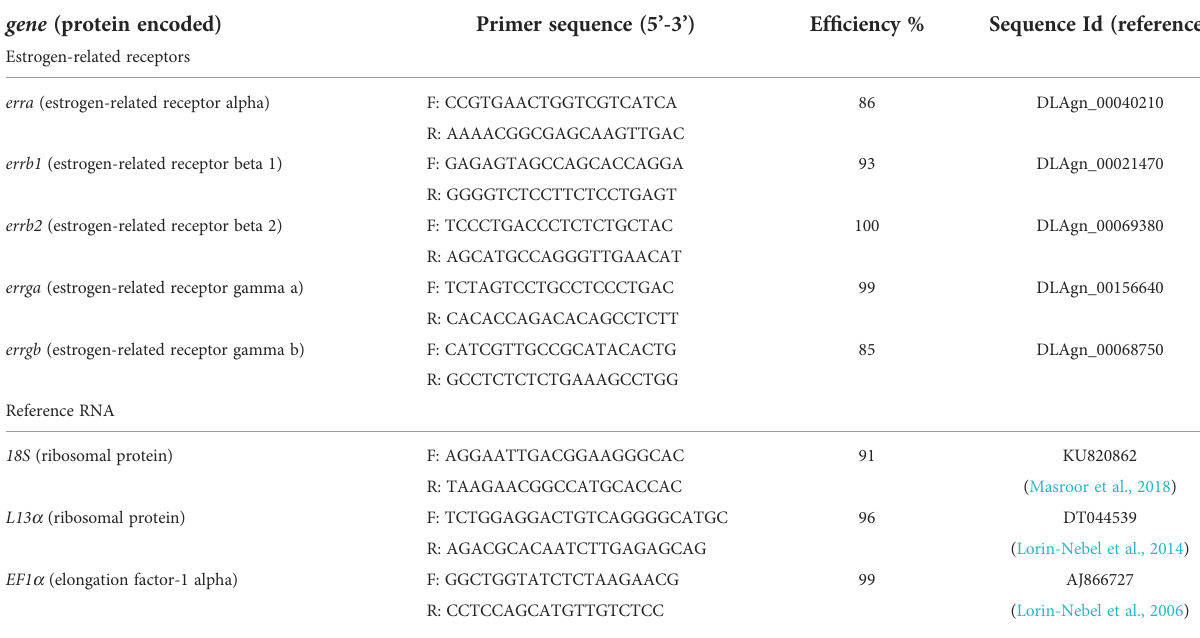
represented in Figure 3. Head mineralization score is positively correlated to the standard length for every treatment with Spearman correlation coef fi cient values ranging between 0.68